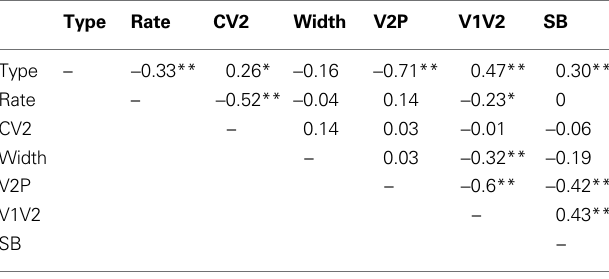
Table 1 | Correlation between cell type and cell